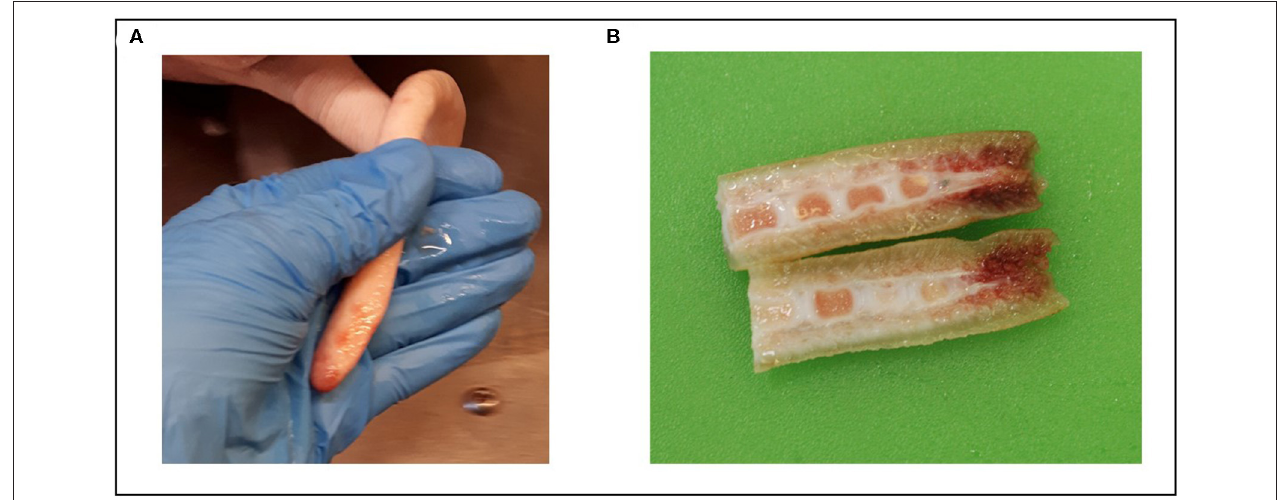
FIGURE 3 | Picture (A) shows a fully intact tail at the slaughter line, showing the flattening tail end, and picture (B) a transversally cut tail end with a lesioned end, but where the flattening shape of the last vertebrae is visible. Panel (A) was generated by Elina Välimäki and Panel (B) was generated by Heli Nordgren.